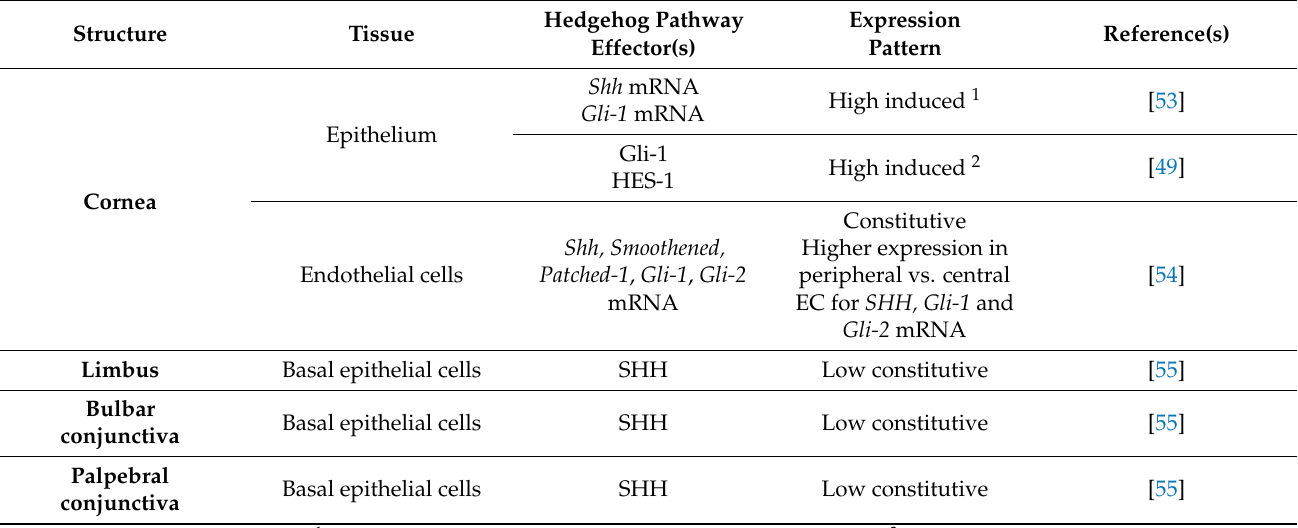
Table 3. Distribution of Hedgehog pathway effectors in the ocular surface of humans (EC =